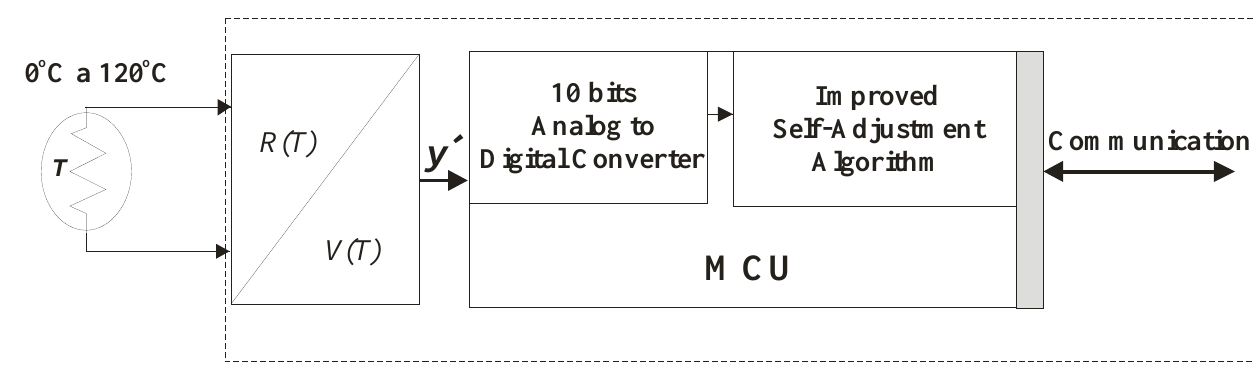
Figure 8. Topology of the intelligent